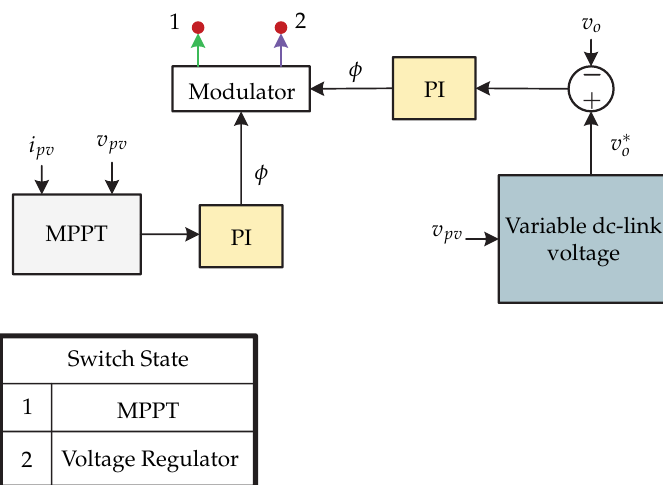
Figure 19. Control strategy proposed in [27].